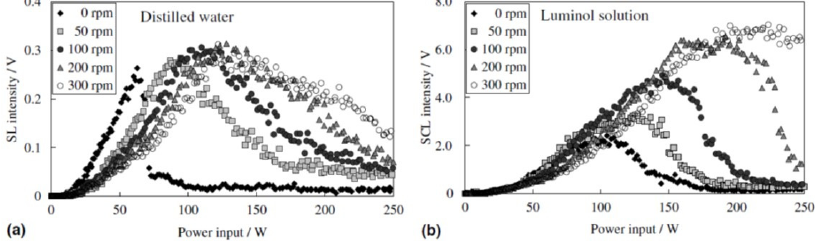
Figure 32. Dependence of intensities of sonoluminescence (SL) ( a ) and sonochemiluminescence (SCL) ( b ) on power input at 99 kHz for various rotational speeds of stirrer [70]. Copyright 2006, with permission from Elsevier.